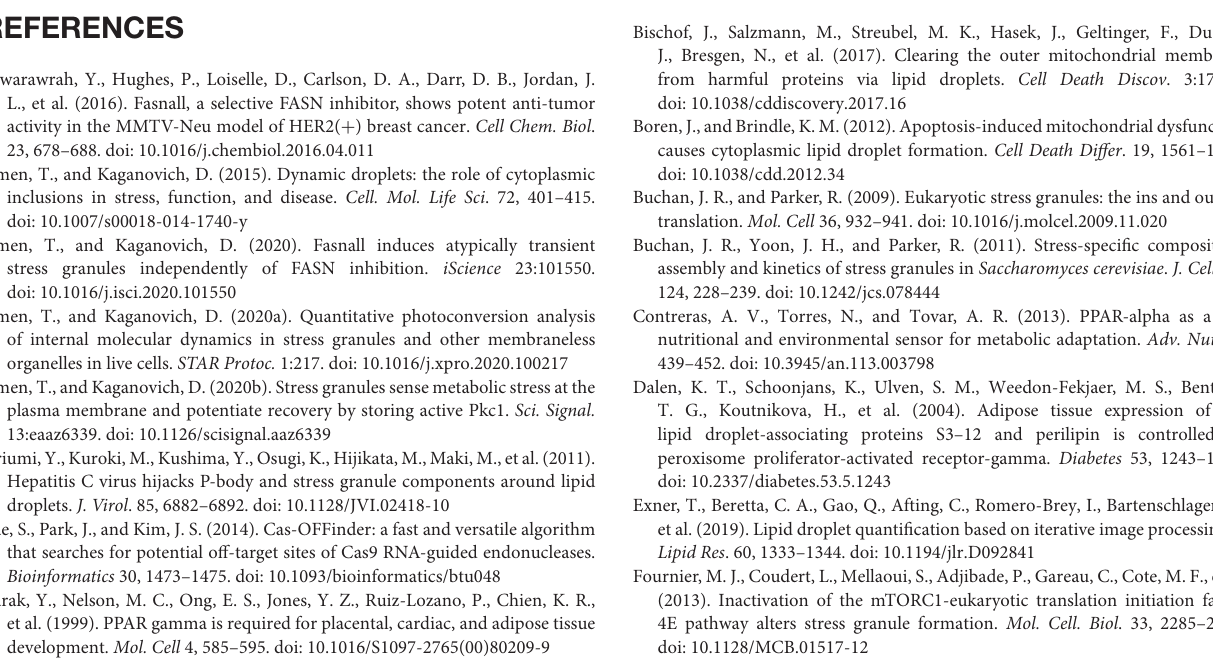
Supplementary Figure 1 | Inhibitor screen for fatty acid accumulation and SG formation. Cells expressing PABPC1-DDR2 were seeded on a 96-well glass-bottom plates and grown to 80–90% confluency. One hundred thirty-six inhibitors (100 µ M) were added to the media for 1h, and fatty acid dye (Bodipy-C12, Red, 1 µ M) was added 30min prior to the experiment. Cells were visualized by confocal microscopy; inclusion formation and fatty acid accumulation was assessed. Confocal images of all the samples are shown, refer to Figure 4C for zoomed in images. “ ∗ ” fluorescence from the inhibitor. Supplementary Figure 2 | (A) Quantification of SG formation and LD accumulation during Fasnall treatment (corresponding to Figure 2B ). Graph